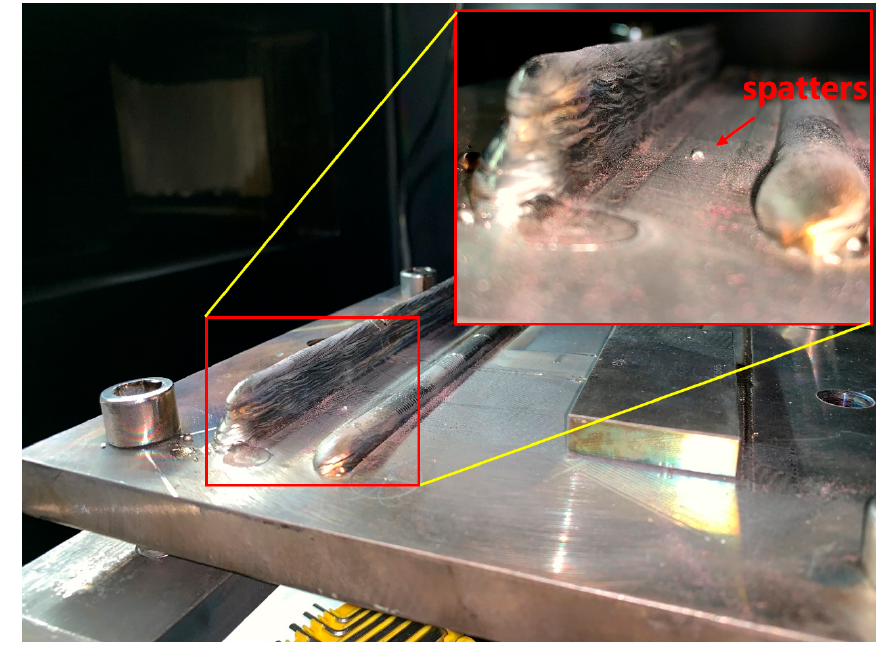
Figure 21. Spatter on the deposit surface.